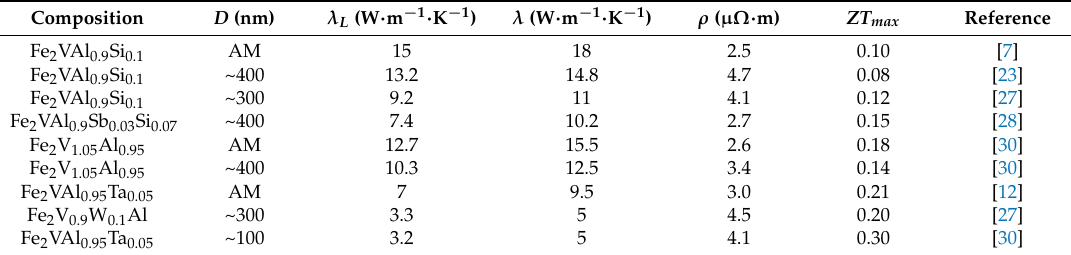
Table 2. Average grain size ( D ), thermal, and electronic transport properties in various nanostructured and substituted Fe 2 VAl alloys at 300 K except ZT max which is the maximum value of the dimensionless thermoelectric figure of merit as a function of temperature. “AM” stands for arc